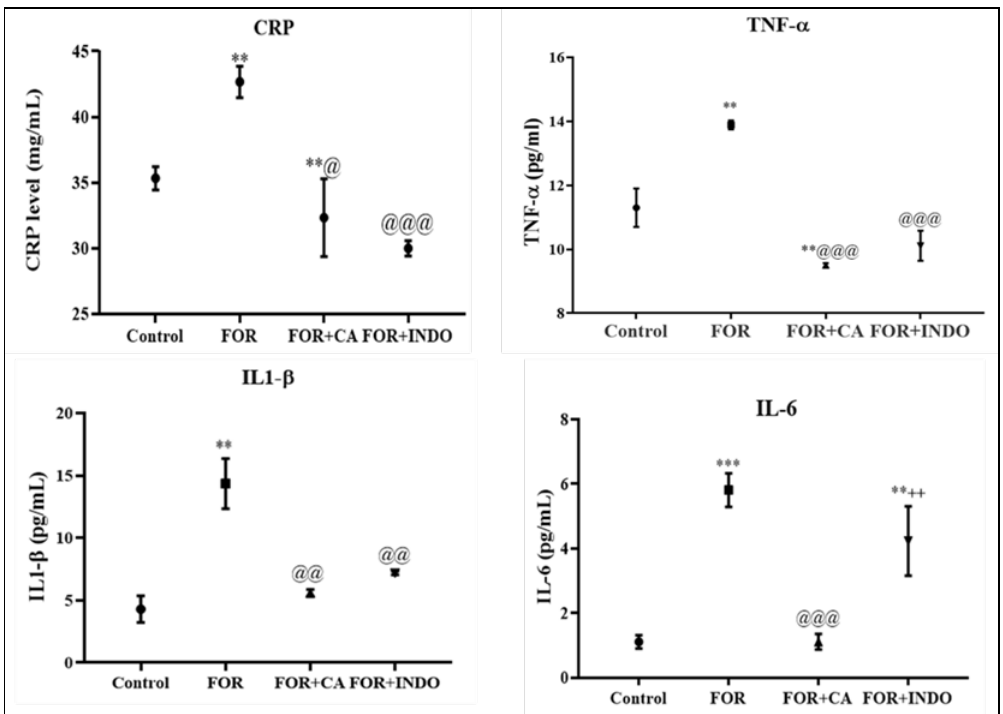
Figure 3. CRP and proinflammatory cytokines levels of experimental groups ** p < 0.05, *** p < 0.001 vs. control group; @ p < 0.05, @@@ p < 0.01, @@ p < 0.01 vs. FOR group; ++ p < 0.01 vs. FOR+CA group.